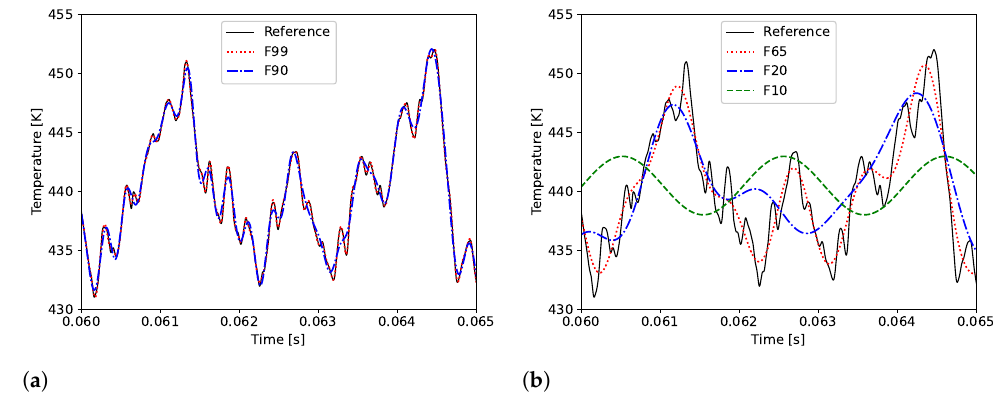
Figure 14. Evolution of the spatial average of static temperature at the inlet plane (green plane of Figure 11). ( a ) F99, F90. ( b ) F65, F20,